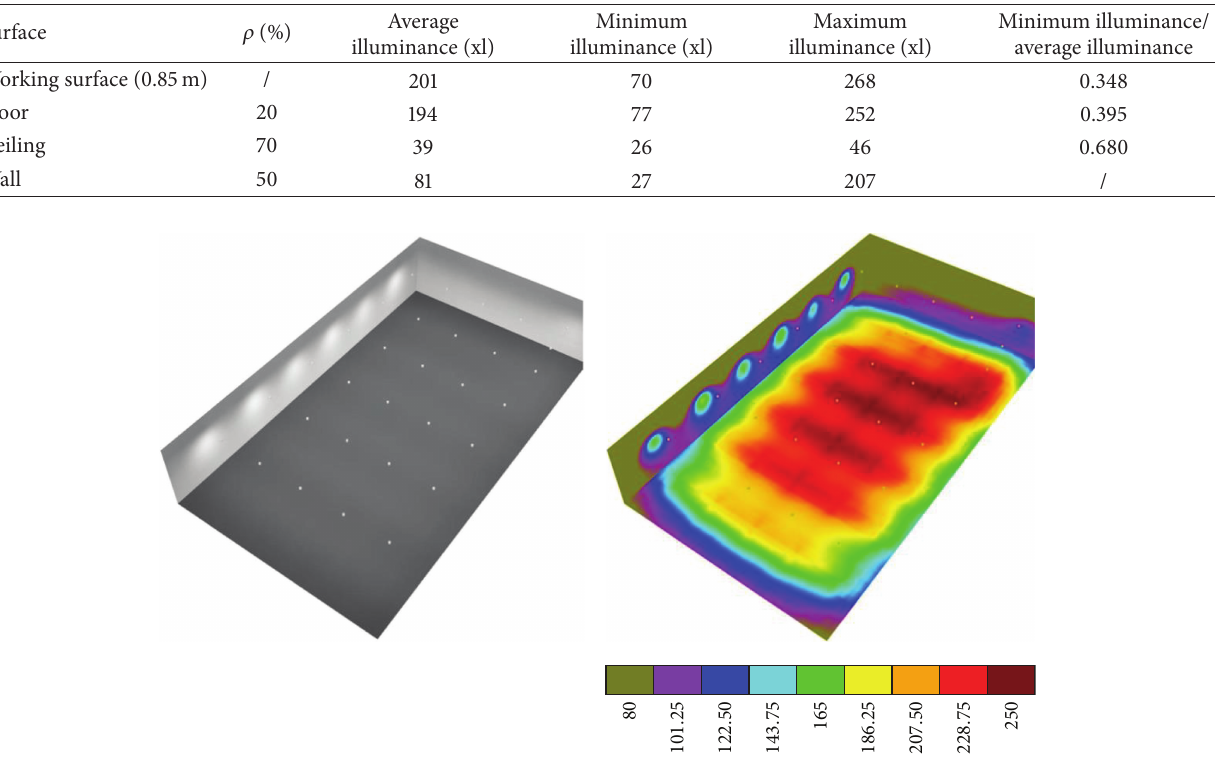
Figure 6: The 3D simulation illuminance of natural light guidance systems in the visitor centre.